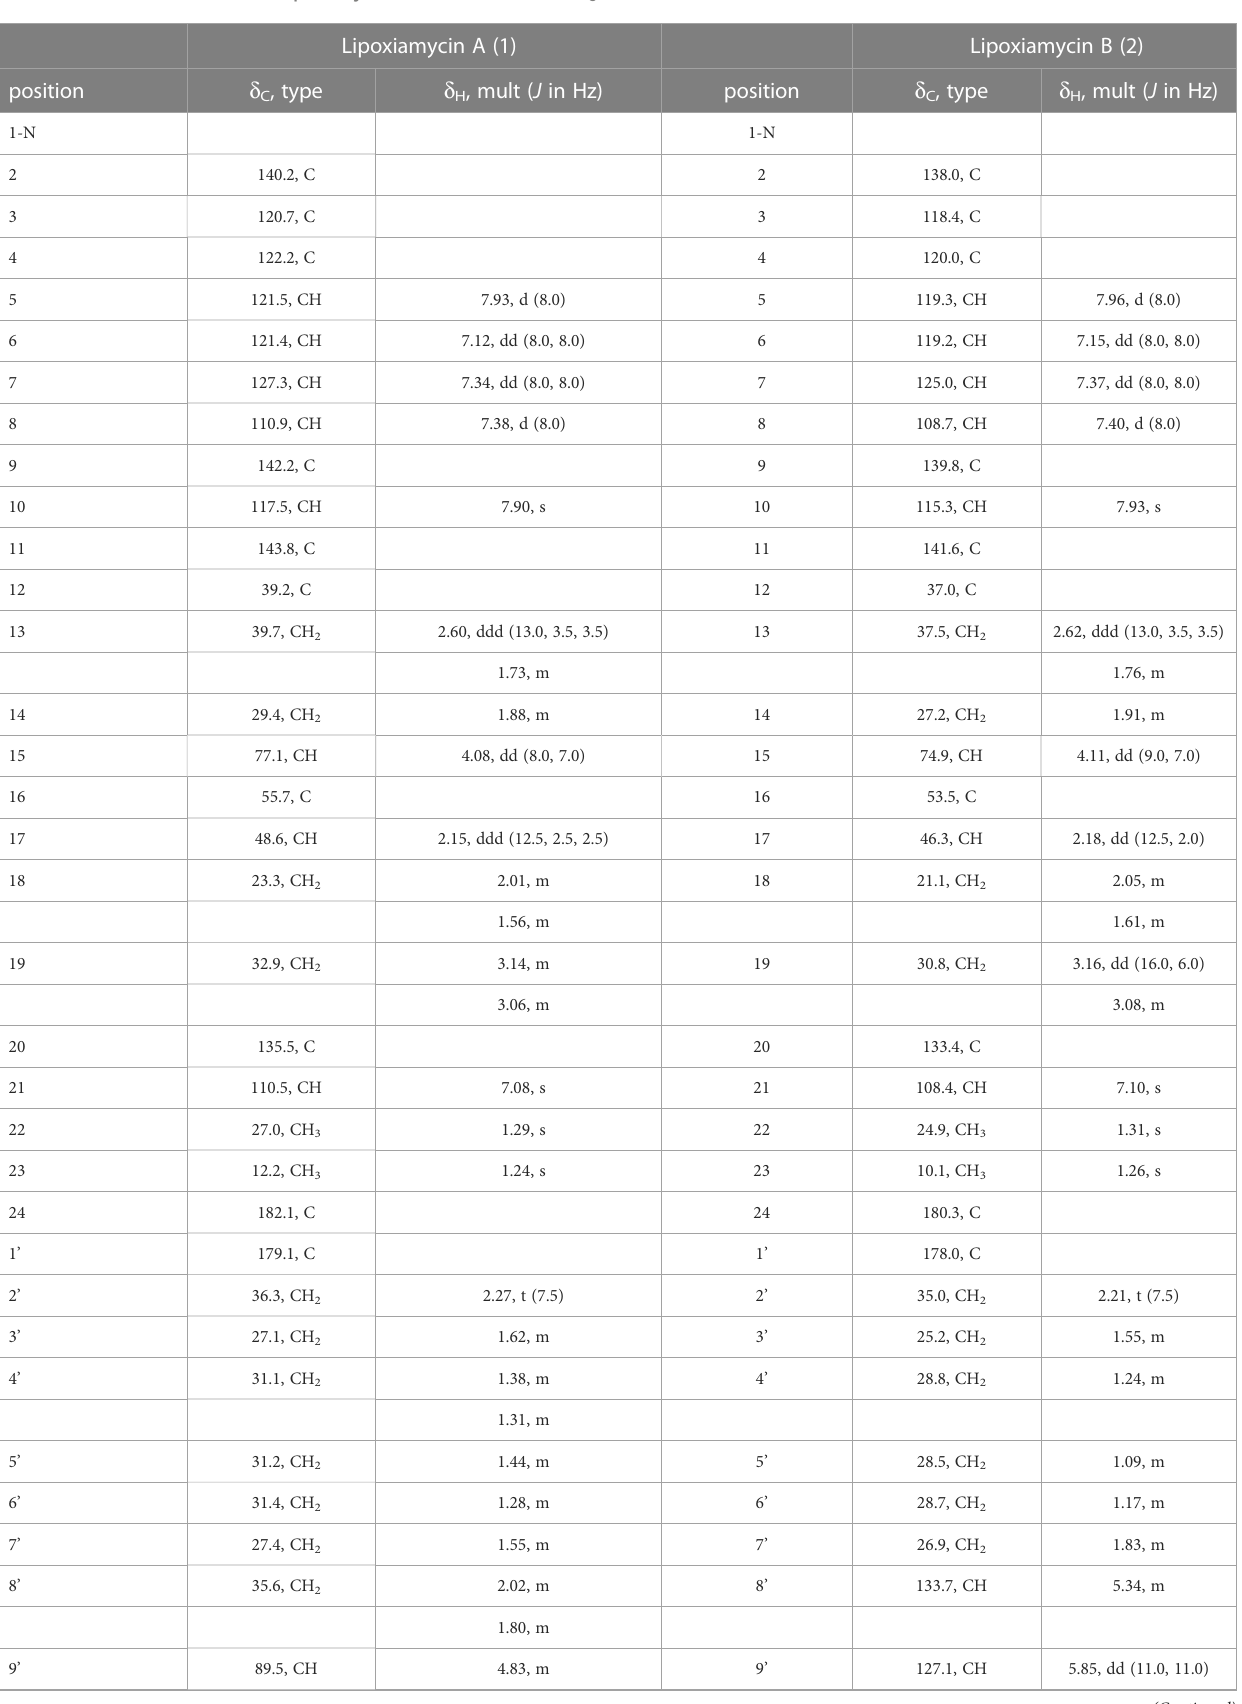
TABLE 1 1 H and 13 C NMR data for lipoxiamycins A and B ( 1 and 2 ) in CD 3